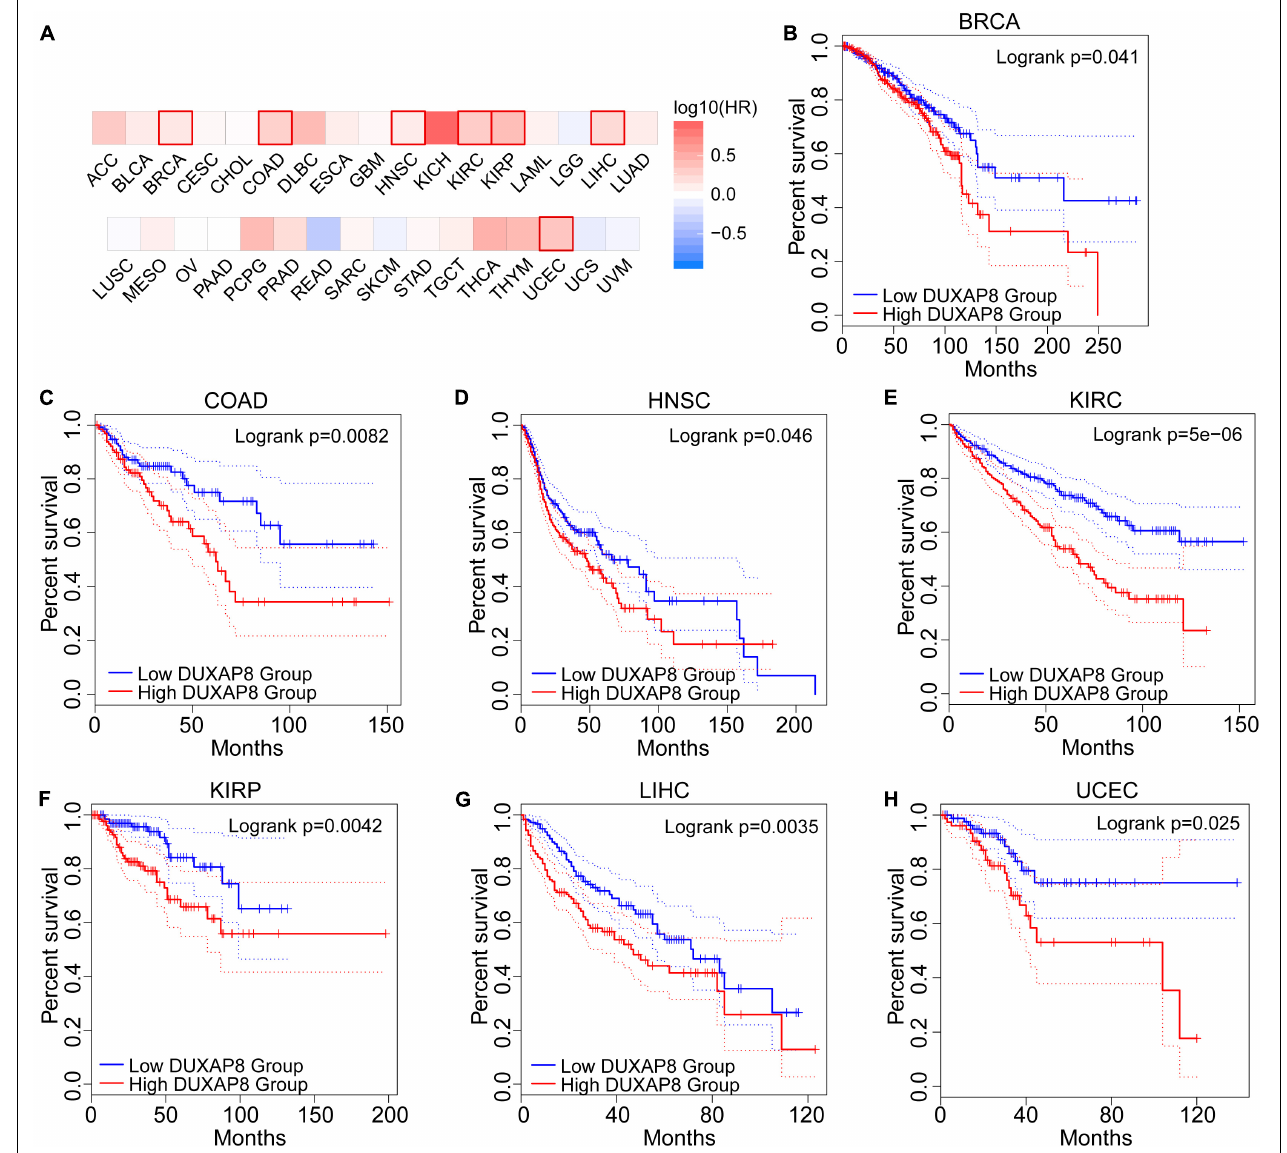
FIGURE 2 | The prognostic prediction of DUXAP pattern in different cancer types. (A) DUXAP8 expression correlated with poor overall survival in seven cancers. (B–H) , patients with overexpressed DUXAP8 had a shorter survival time than patients with downregulated DUXAP8 expression in breast invasive carcinoma (BRCA) ( p = 0.041), COAD ( p = 0.0094), HNSC ( p = 0.047), KIRC ( p = 7.6e–6), KIRP ( p = 0.0057), LIHC ( P = 0.0038), and UCEC ( p =